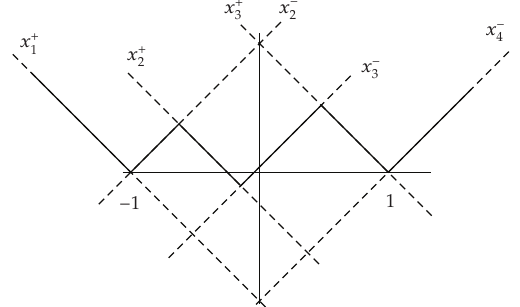
Figure 7: A zig-zaged Wilson loop in 1 (cid:8) 1 dimensions is parameterized by nx (cid:8) coordinates. If you want a closed polygon, you can fold the figure in a